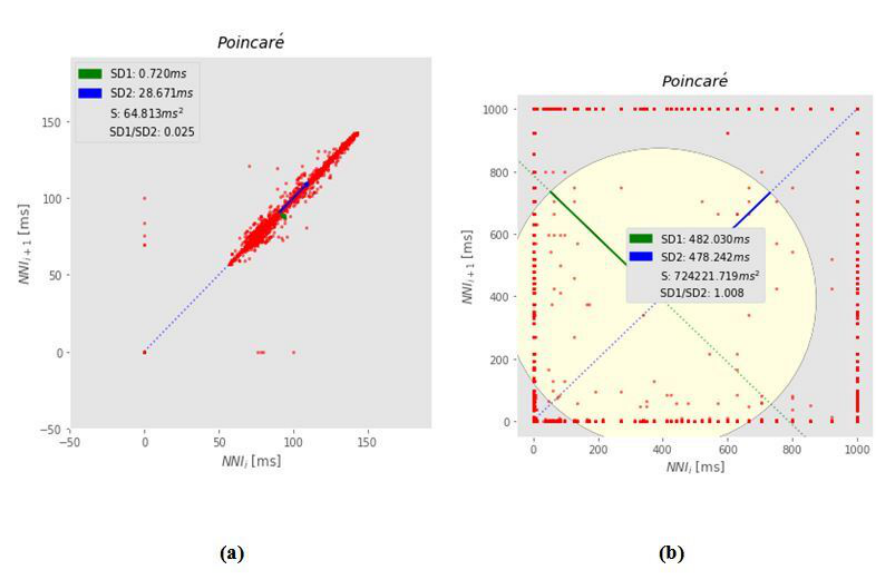
Figure 13. ( a ) Shows Noisy HR patterns using poincare plot. ( b ) Shows Normal HR of user after data